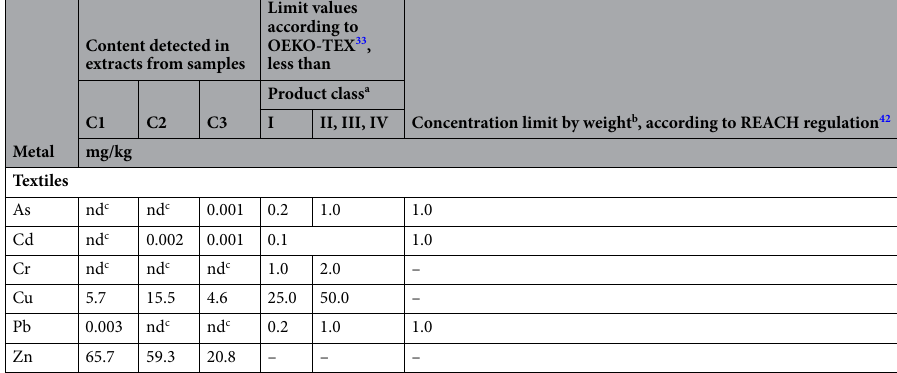
Table 4. As, Cd, Cr, Cu, Pb and Zn content in the extracts obtained from textiles and limits for their content according to OEKO-TEX and REACH Regulation. Source: Author’s own research, limits of metal content based on the OEKO-TEX 33 —Annex IV and REACH Regulation 42 —Appendix 12. a I—products for infants and young children up to 36 months of age, II—products in direct contact with the skin, III—products in no direct contact with the skin, IV—decorative products; b after extraction, expressed as As, Cd and Pb metal respectively, that can be extracted from the material; c not detected.